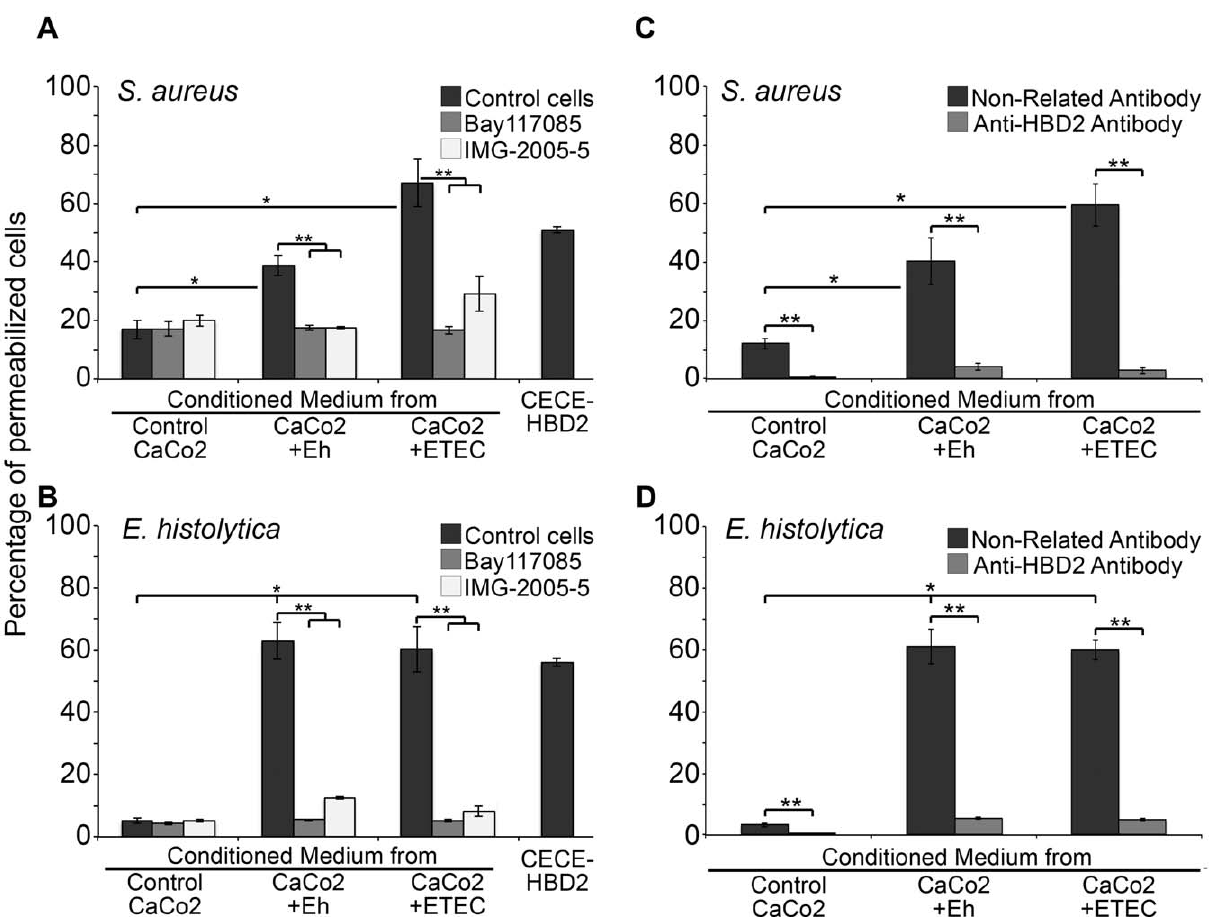
Figure 3. Permeabilizing effect of HBD2 released by CaCo2 cells after exposure to Entamoeba histolytica trophozoites. A. Permeabilization of Staphylococcus aureus bacteria, a known strain sensitive to HBD2 activity, by CM from CaCo2 cells exposed to pathogens. One hundred thousand bacteria from an overnight culture were exposed for 1 h to CM from CaCo2 cells exposed to ETEC (CaCo2 + ETEC, positive control), to CM from cells exposed to PFA-fixed trophozoites (CaCo2 + Eh) or incubated with 10 ng/ml of CECE-HBD2. Propidium iodide internalization into permeabilized bacteria was quantified by flow cytometry. B. Permeabilization of E. histolytica trophozoites by CM from CaCo2 cells exposed to pathogens. One hundred thousand trophozoites were exposed to CM from CaCo2 cells exposed to ETEC (CaCo2 + ETEC, positive control), to CM from cells exposed to PFA-fixed trophozoites (CaCo2 + Eh) or incubated with 10 ng/ml of CECE-HBD2. In parallel, CM from CaCo2 cell cultures also exposed to either pathogen and incubated with inhibitors of the TLR2/4-NF k B pathway, Bay117085 and IMG-2005-5, were used to permeabilize S. aureus bacteria or E. histolytica trophozoites. Propidium iodide internalization into trophozoites was quantified as indicated for bacteria. C and D. Neutralization of HBD2 activity present in CM. Media obtained from CaCo2 cell cultures exposed to pathogens were neutralized with anti-HBD2 antibody (2.0 m g/ml for 2 h); then, S. aureus bacteria or E. histolytica trophozoites were incubated with these neutralized media. As control, a non- related polyclonal antibody (anti-human Sirt1) was used. Permeabilization levels were evidenced by propidium iodide penetration and quantified by flow cytometry. Data for all panels are presented as percentage of permeabilized cells 6 SD. * indicates differences between control cells and cells exposed to pathogens. ** Indicates statistical differences between inhibited (panels A and B) or neutralized (panels C and D) conditions versus values obtained in non-inhibited or non-neutralized conditions in three experiments done in triplicate ( P value , 0.01). micrographs of trophozoites treated as indicated in figure 4A. In HBD2. Figure 4A (panel a) depicts a representative trophozoite panels b, c and d, it is possible to appreciate a notorious increase in incubated in CM from control CaCo2 cells. It shows a continuous the number of vacuoles (v) and glycogen accumulation (g), plus plasma membrane, the typical small accumulations of cytoplasmic chromatin aggregation and its polarization inside the nucleus (N), glycogen (g) and well-formed vacuoles with clear content and and other signs of cell lysis, such as the extruded cytoplasm in one continuous membranes (v). In contrast, trophozoites incubated in side of the trophozoite (Figure 4Bb, arrowhead). These alterations CM from CaCo2 cells exposed to Entamoeba histolytica (panel b) or were not observed in trophozoites incubated in CM from CaCo2 to ETEC (panel c), as well as trophozoites incubated with 10 ng/ cells not exposed to pathogens (panel a) nor in those incubated in ml of CECE-HBD2 (panel d) showed membranes, both plasmatic CM from cells exposed to TLR classical pathway inhibitors (not and vacuolar with multiple discontinuous zones and irregular shown). These results corroborated that trophozoite-induced width that could correspond to pores (arrows); together with HBD2 in CaCo2 cells has the capacity to permeabilize bacteria several ruptured points and release of cellular material can be seen and trophozoite membranes. Membrane damage in trophozoites (arrowheads). Also evident, is the increased accumulation of leads to loss of cell integrity and their destruction. glycogen in the cytoplasm (g). Figure 4B shows low magnification